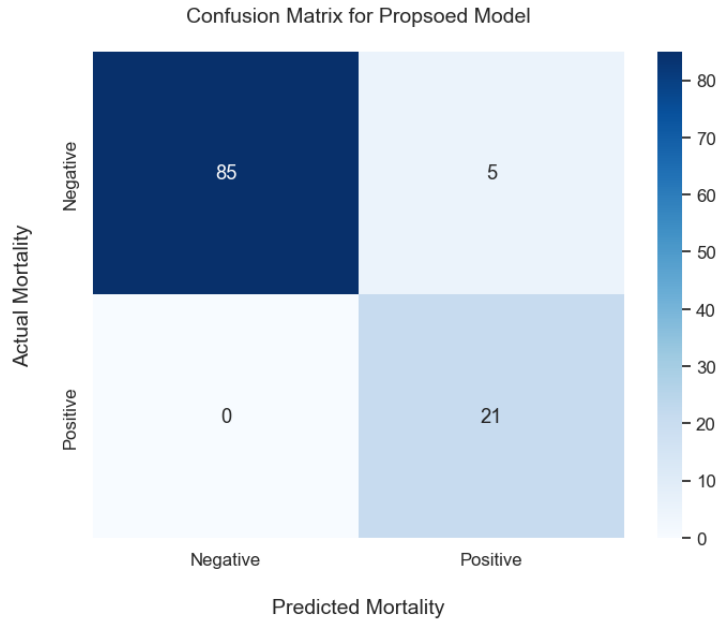
Figure 4. Confusion matrix of the proposed model χ 2 _RF.